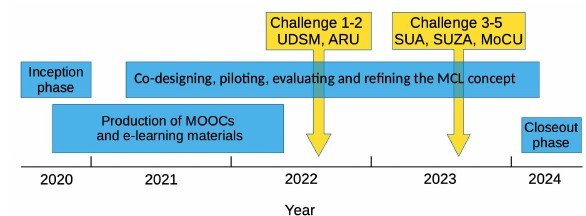
Figure 2. Through co-designed and repetitive CBL campaigns, the MCL methodology develops and is documented into an online MCL Playbook, which contains links to produced e- learning resources and